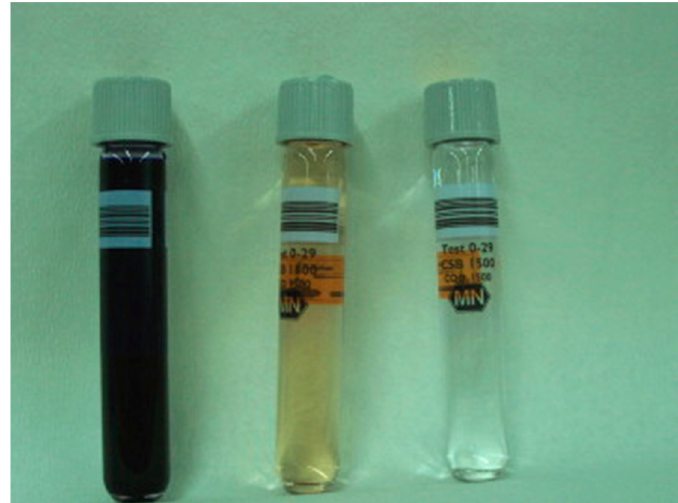
Figure 14. Basic Blue 41 solution ( left ) after oxidation at 450 °C ( middle ) and 600 °C ( right ). Reprinted with permission from [160] . Copyright © 2009 Elsevier.